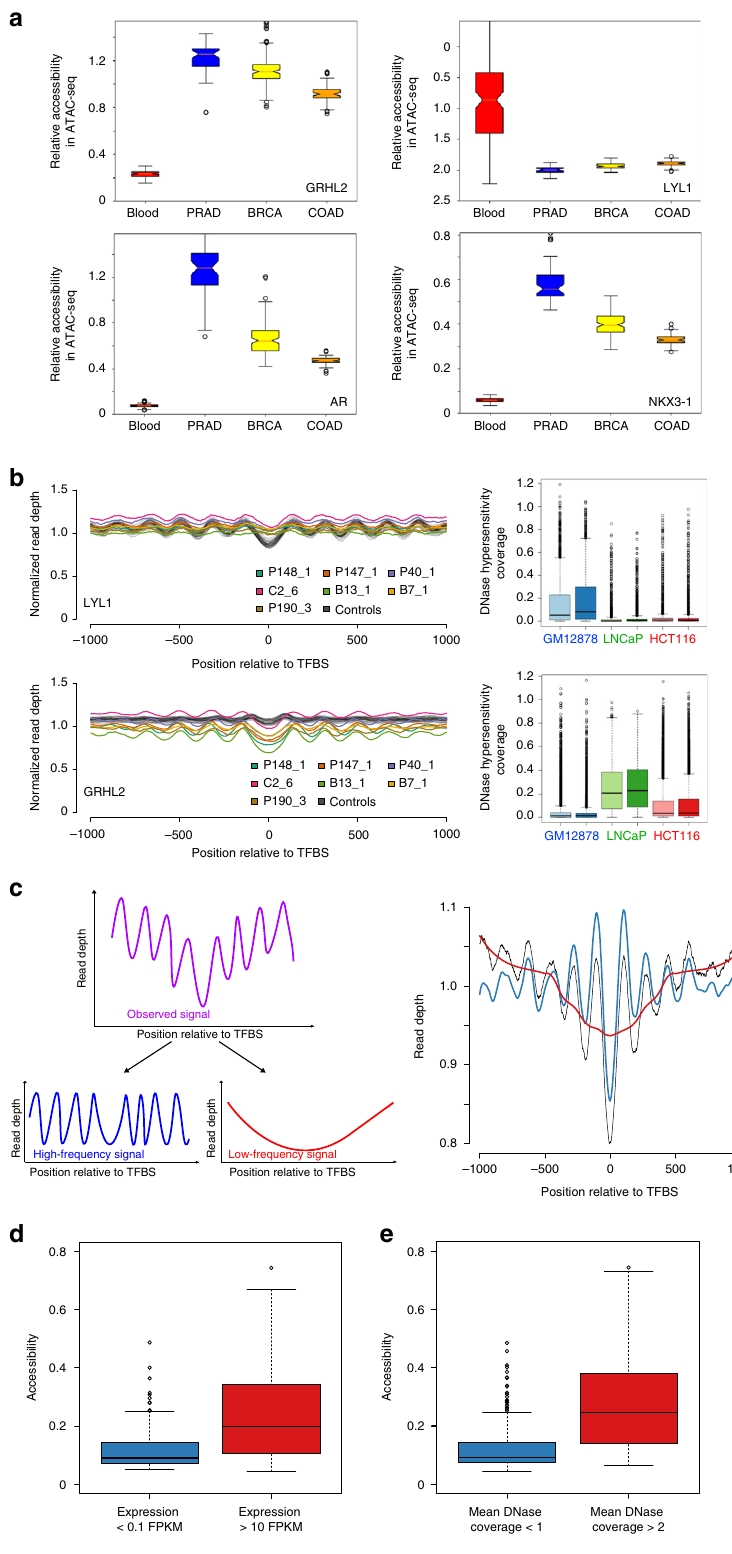
thresholds for TFBS accessibility differences from the mean of rank in normal samples by >5 standard deviations (i.e., a z-score of 5 and − 5, respectively). Histogram analysis and a QQ-plot showed no relevant deviation from a normal distribution (Sup- plementary Fig. 4), suggesting that z-scores are in general applicable for our analyses.